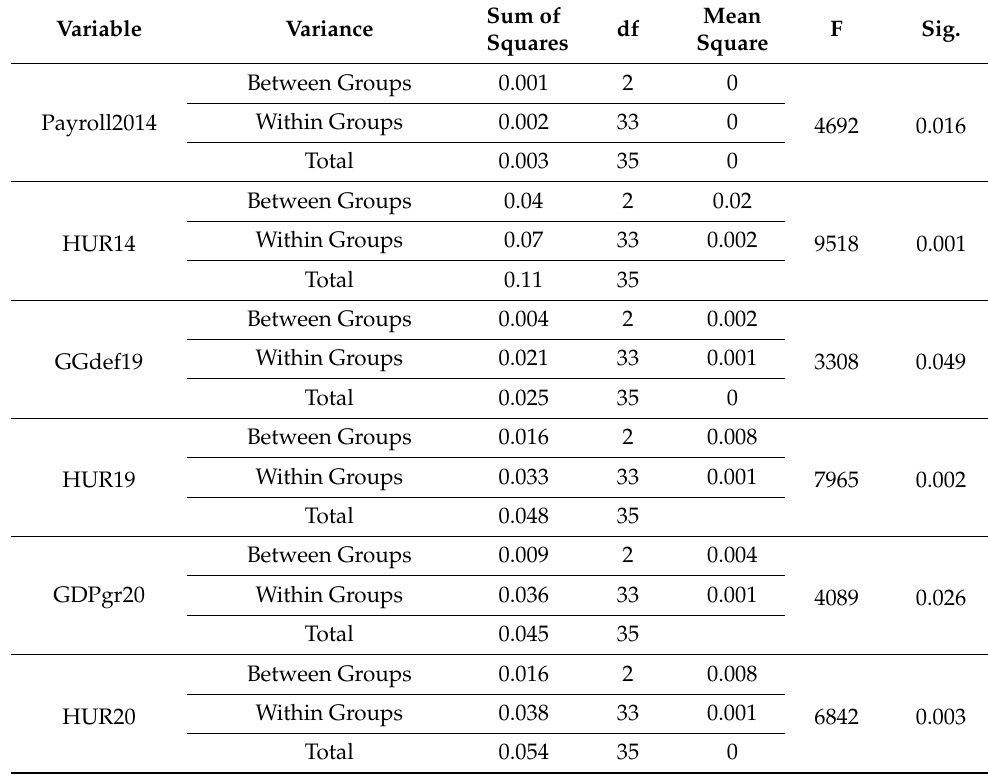
Table 8. Analysis of variance (ANOVA) table